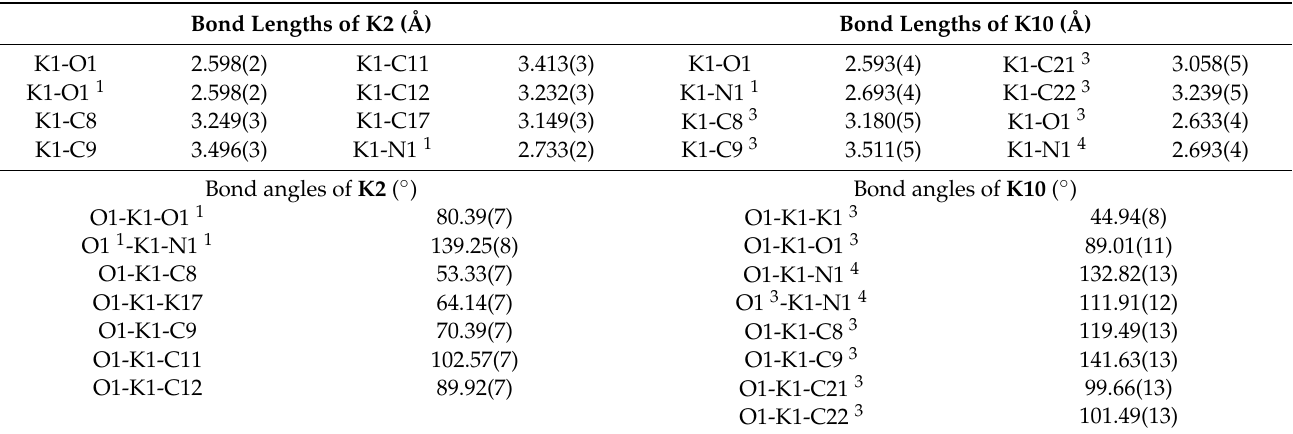
Figure 2. ( a ) Ortep drawing of structure of K10 , with ellipsoids shown at the 30% probability level (left). ( b ) Mercury drawing dimer of K10 through interaction (middle). ( c ) A section of the packing diagram in K10 (right).